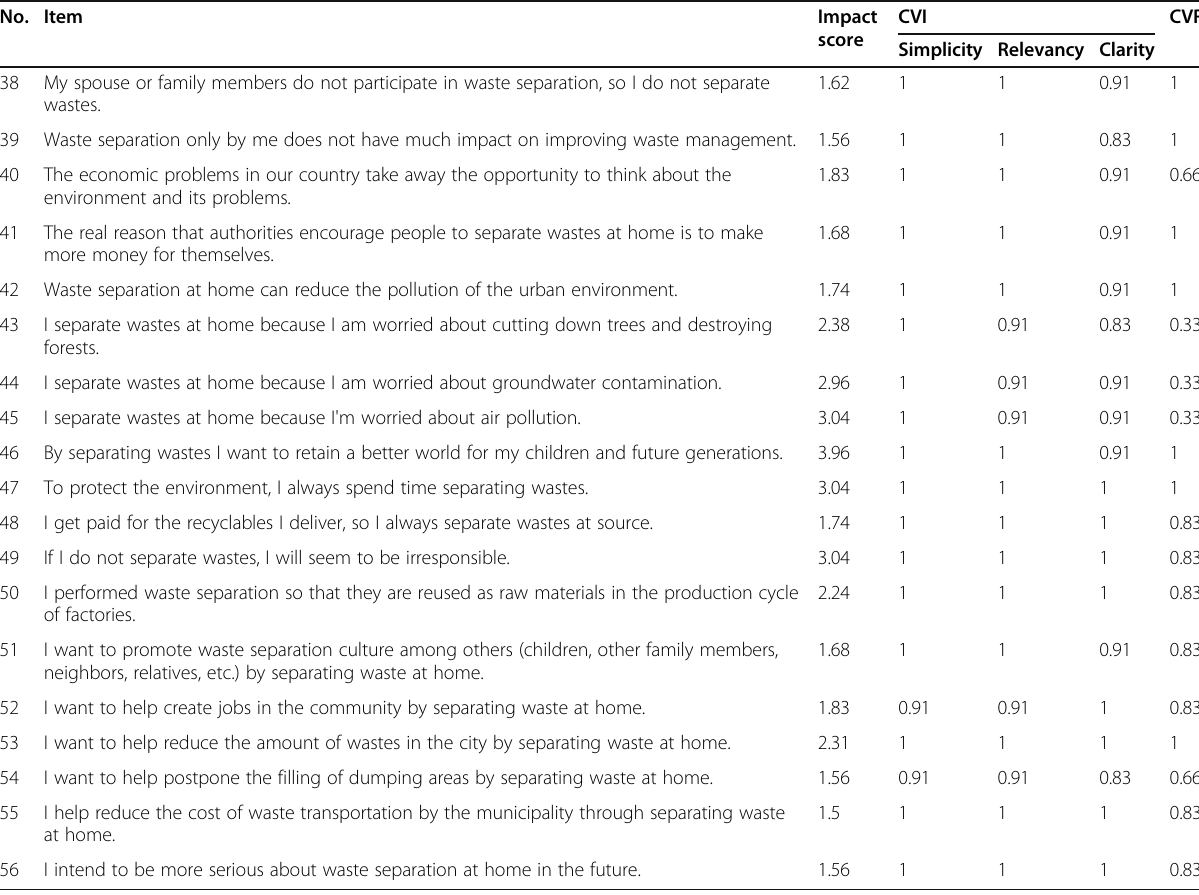
Table 1 Results of face and content validity of the instrument (Continued) No. Item